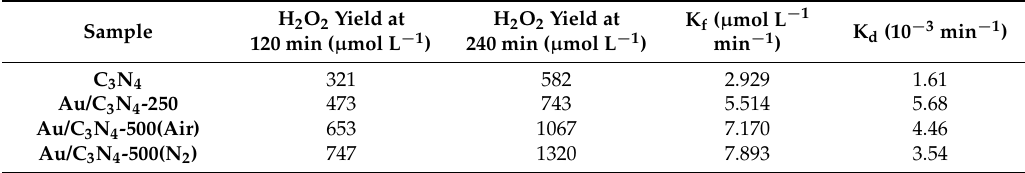
Table 2. The yield of hydrogen peroxide (H 2 O 2 ) and the kinetic analyses.